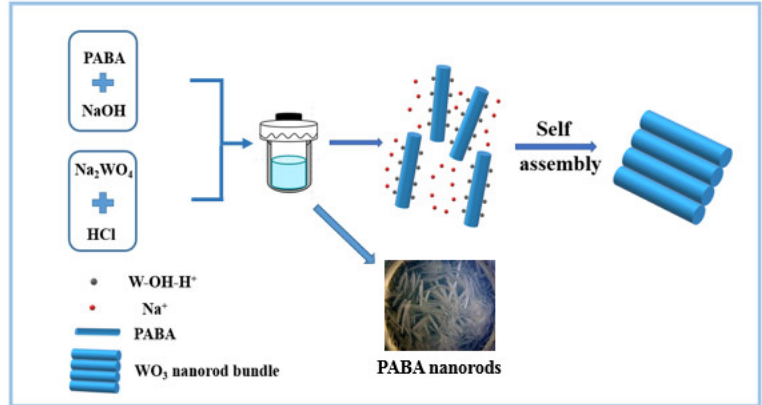
Figure 4. Schematic illustration of WO 3 · 0.33H 2 O nanorod bundles through a self-assembly step.